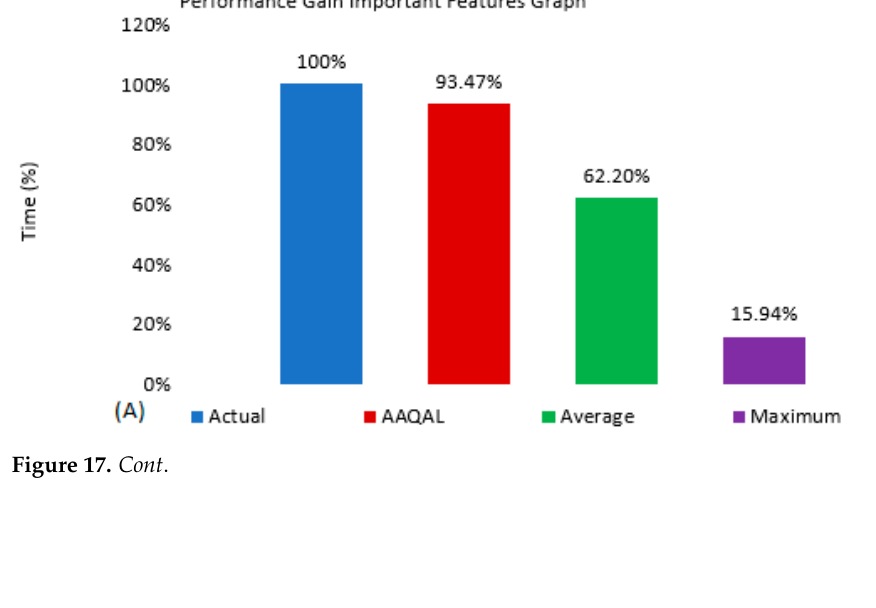
Figure 16. Performance gain with basic features ( A ) and execution time comparison ( B ) with basic features (test set).